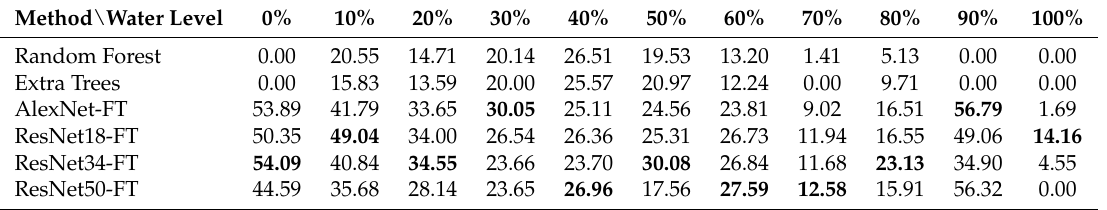
Table 8. Per-class F1 score for each method—Reg2Class10 training setting.